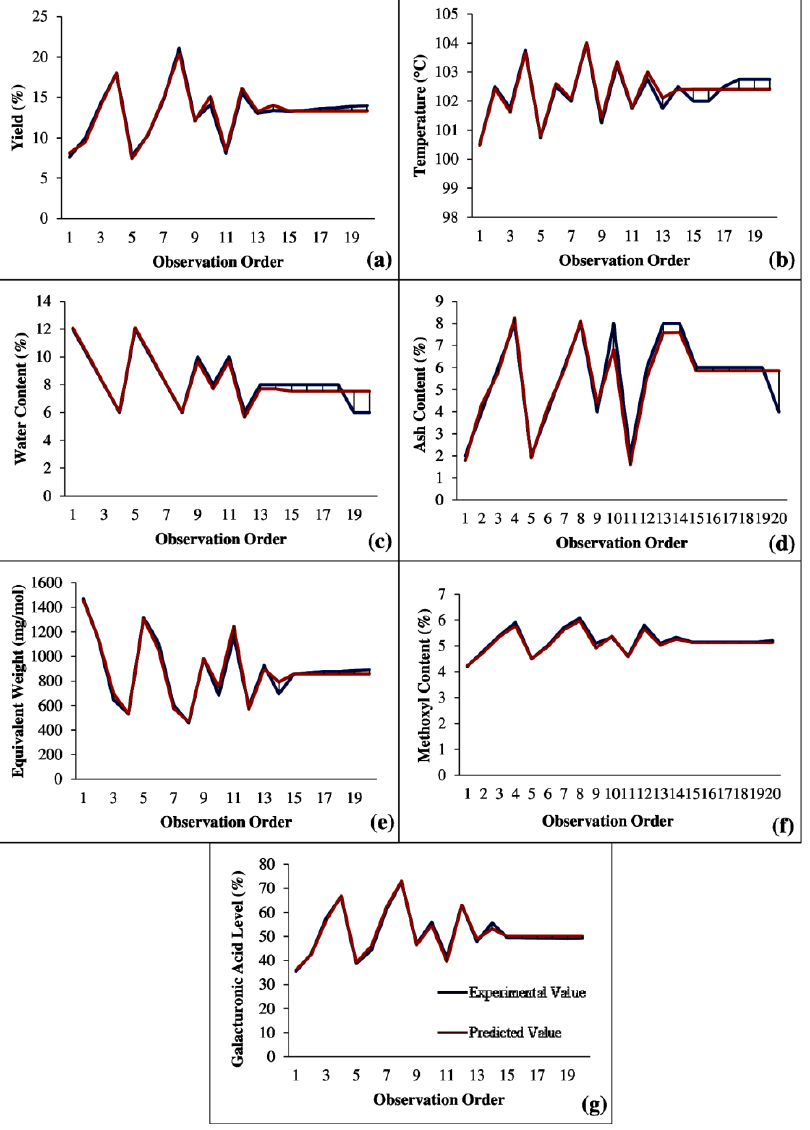
Figure 1. Comparison graph of experimental value and predicted value: ( a ) yield; ( b ) temperature; ( c ) water content; ( d ) ash content; ( e ) equivalent weight; ( f ) methoxyl content; ( g ) galacturonic acid content. Table 1. Standard deviation and error of model equation. Parameter Standard Deviation